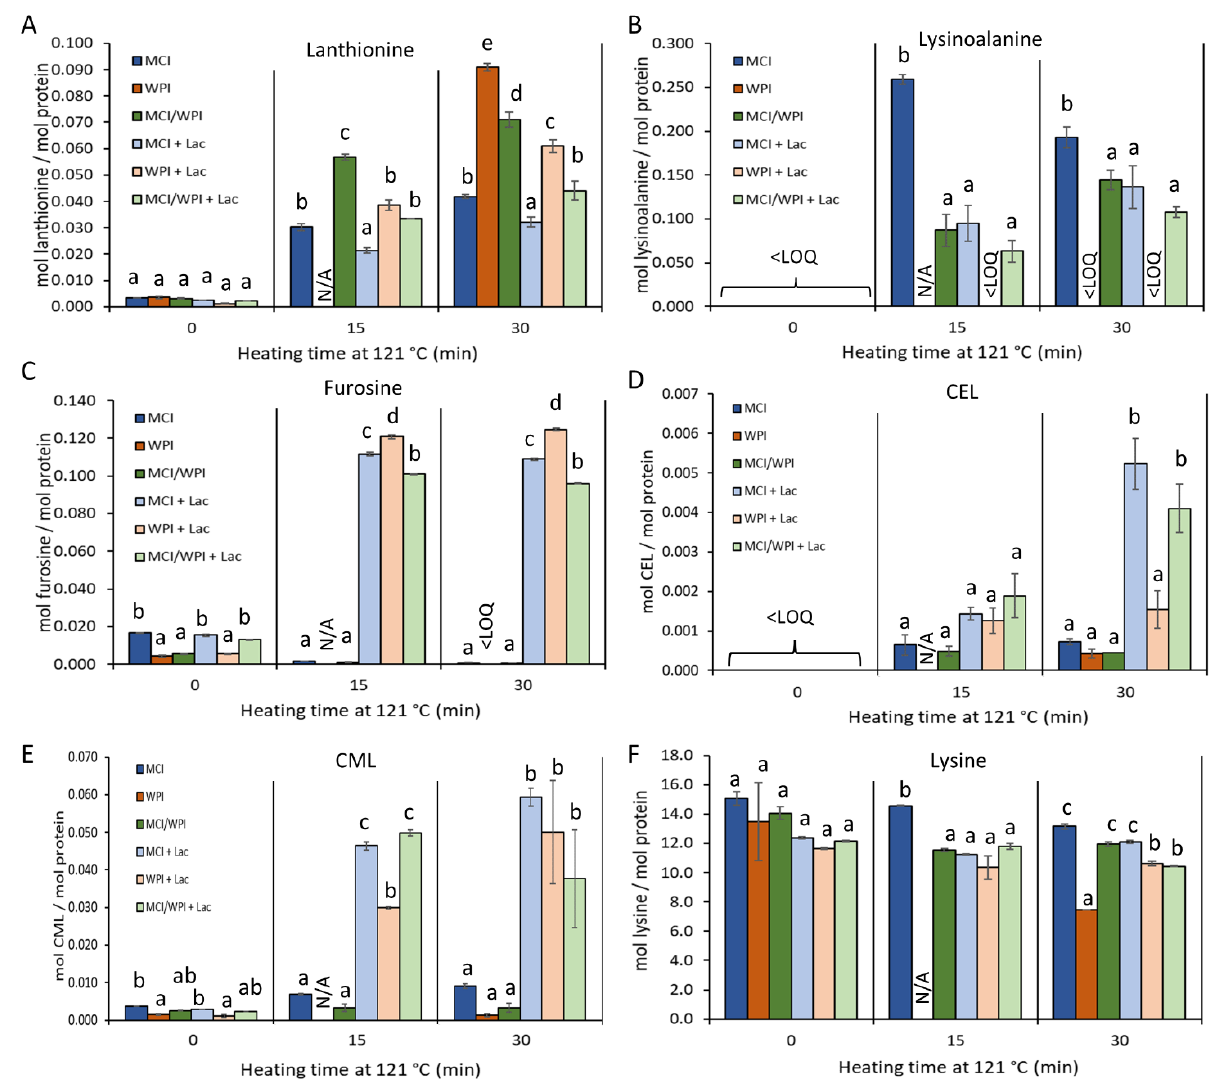
Figure 3. Absolute quantities of DHA-mediated protein cross-links (lanthionine ( A ) and lysino- alanine ( B )), the Maillard-reaction-derived products (furosine ( C ), CEL ( D ), CML ( E )) and the amino acid lysine ( F ) in micellar casein isolate (MCI), whey protein isolate (WPI) or in a combination mimicking their ratio in milk (80:20), heated for 0, 15 or 30 min at 121 °C, in the presence or absence of lactose. Different letters indicate significantly different values ( p < 0.05) in relation to heating (0, 15 or 30 min).